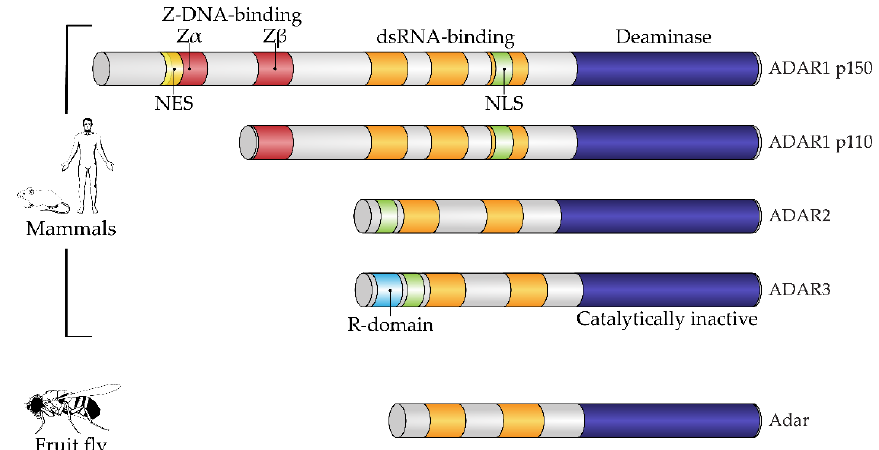
Figure 1. Domain architecture of mammalian and fruit fly ADAR family members. All proteins of the ADAR family share a common domain architecture and include a variable number of dsRNA-binding domains (dsRBDs) and a catalytic deaminase domain. In addition, human ADAR1 isoforms and their orthologs also contain Z-DNA-binding domains. A constitutive isoform, ADAR1 p110, contains the so-called Z β domain, which adopts a fold similar to Z α domains but is not able to bind a Z-form of nucleic acid. Interferon-inducible ADAR1 p150 has an extended N-terminus containing a Z α domain, which harbors a nuclear export signal (NES). ADAR3, a catalytically inactive member of the family, additionally contains an R-domain. Fruit flies have a single Adar, which is most similar to mammalian ADAR2. NES, nuclear export signal; NLS, nuclear localization signal; R-domain, arginine-rich domain. Figure composed based on [15], with